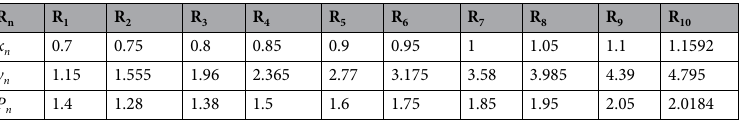
Table 1. x n is the short axis radius of the n th oval-ring, y n is the long axis radius of the n th oval-ring, p n is the distance between the n th and the n + 1 th oval-ring centers.